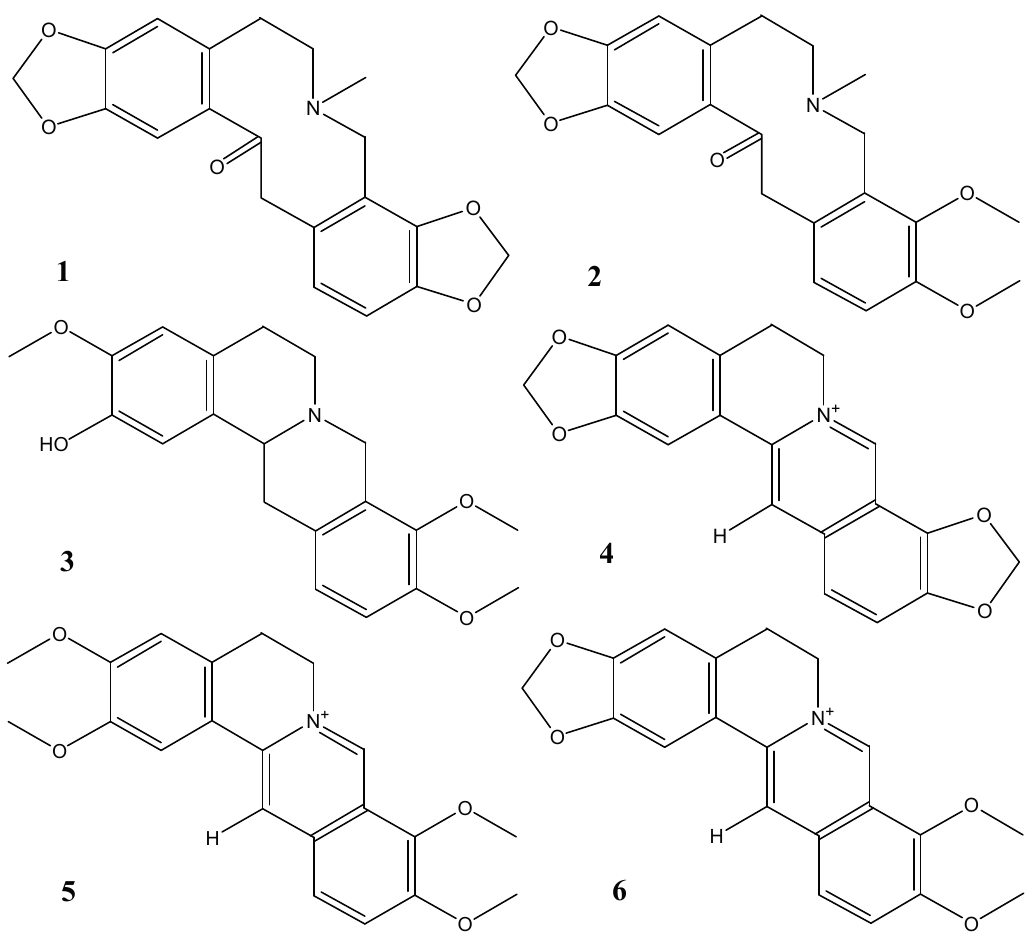
Figure 1. Chemical structures of the main alkaloids detected in Corydalis Rhizoma. Protopine ( 1 ), α -allocryptopine ( 2 ), tetrahydrocolumbamine ( 3 ), coptisine ( 4 ), palmatine ( 5 ), berberine ( 6 ), dehydrocorydaline ( 7 ), D , L -tetrahydropalmatine ( 8 ), tetrahydroberberine ( 9 ), corydaline ( 10 ), tetrahydrocoptisine ( 11